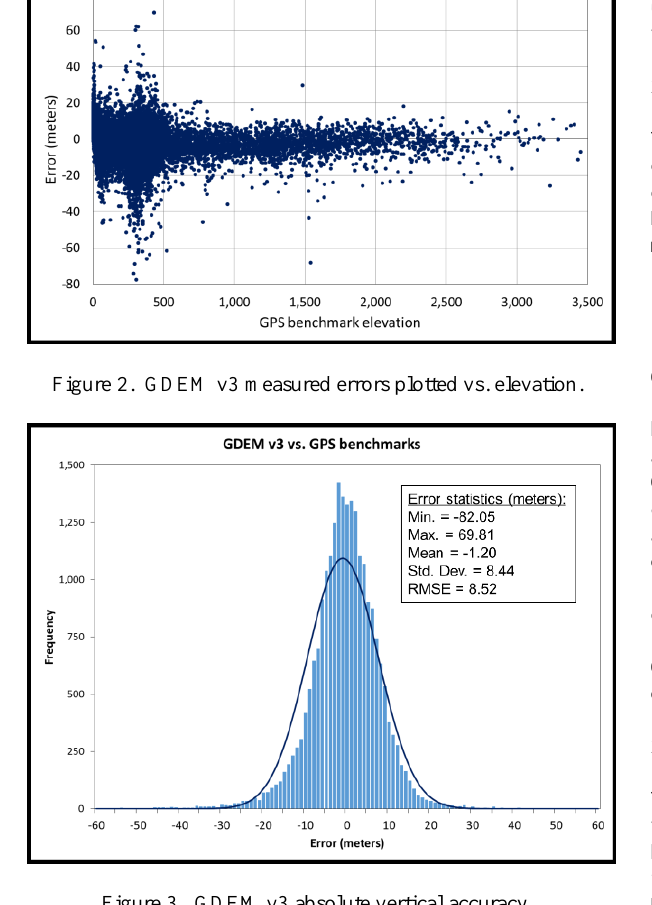
Figure 3. GDEM v3 absolute vertical accuracy.